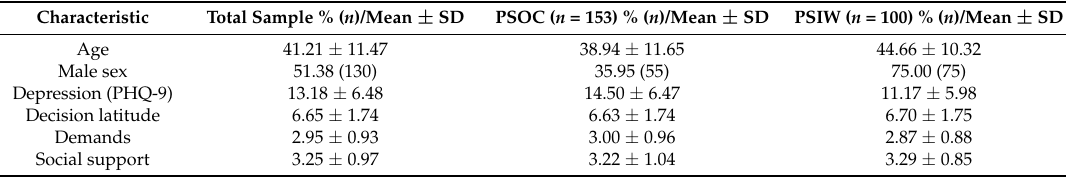
Table 1. Descriptive characteristics of the sample ( n = 253).